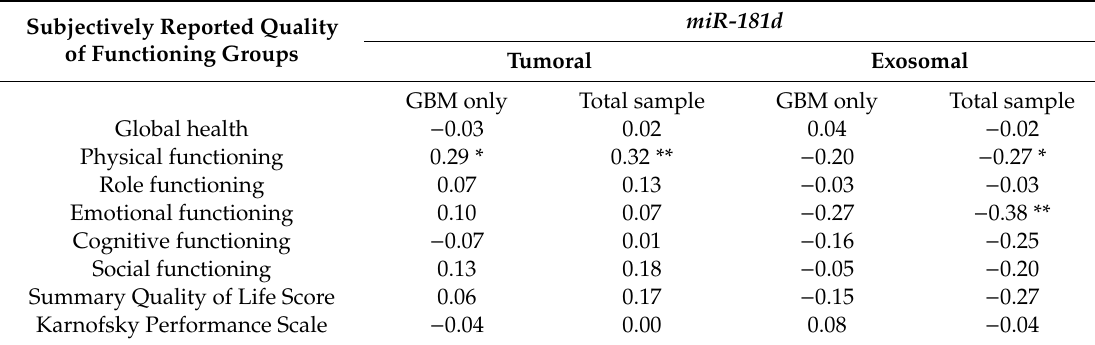
Table 2. Correlations between miR181d expression and subjectively reported quality of functioning. Subjectively Reported